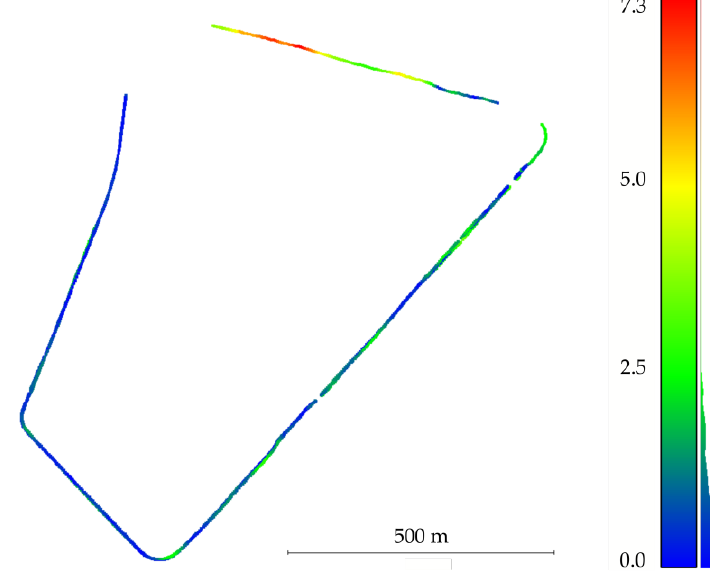
Figure 8. Error of horizontal positioning with a satellite compass m d [m].